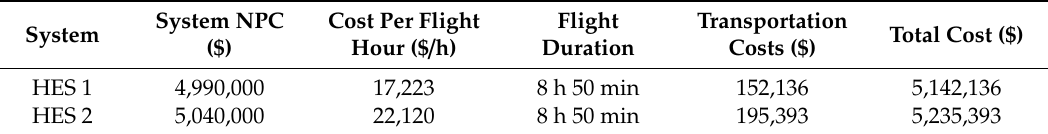
Table 7. The purchase and airlift total cost of HES 1 and 2 to Clark Air Base.